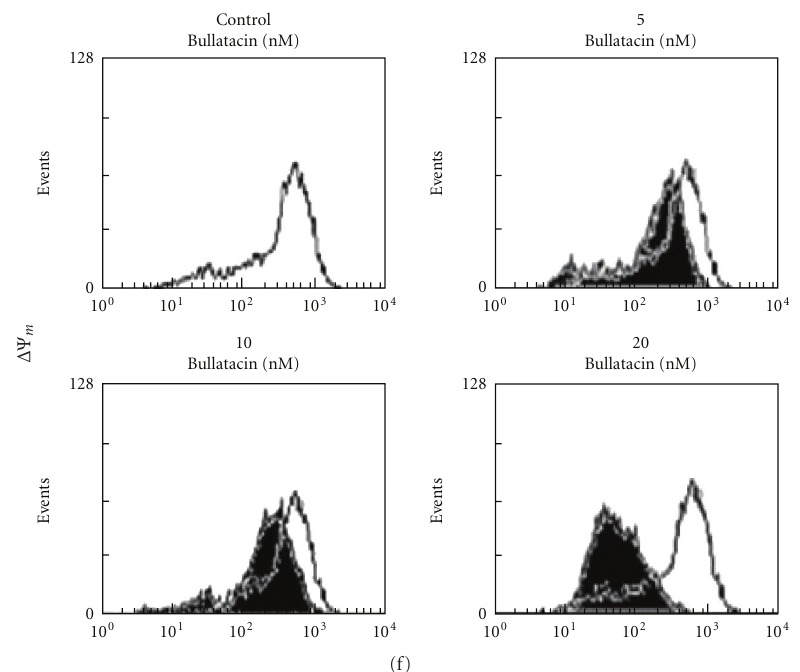
Figure 2: Apoptosis, ROS level and mitochondrial transmembrane potential ( ΔΨ m ) were determined in KB or KBv200 cells after treatment with bullatacin. (a) Apoptotic morphology of KB and KBv200 cells ( × 400) was observed by Hoechst 33258 staining. The experiments were performed three times and a representative experiment is shown. (b) The apoptotic rates of KB and KBv200 cells were calculated with identified apoptosis cells by Hoechst 33258 stain dividing to accounted all cells (more than 2000 cells) after treated with bullatacin for 48 hours. Data represented means and standard errors of at least a triplicate determination. (c) Apoptotic cells were detected with Annexin V/PI after bullatacin treatment for 48 hours. The left-upper quadrant represents cells stained mainly by propidium iodide, while the right bottom quadrant represents cells stained mainly by Annexin V (apoptotic cells). The top right quadrant represents cells stained by both PI and Annexin V (secondary necrosis). The experiments were performed three times and a representative experiment is shown. (d) The apoptotic rates of KB and KBv200 cells was examined with Annexin V/PI after treated with bullatacin for 48 hours. Data represented means and standard errors of at least a triplicate determination. (e) ROS levels detection in KBv200 cells after treatment with bullatacin for 12 hours. Relative ROS levels were represented by the fold DCF intensity compared with untreated cells. The samples were duplicated and the data is a representative of three experiments. (f) Assessment of ΔΨ m collapse in KBv200 cells. The collapse of ΔΨ m was indicated by a reduction of DiOC 6 intensity because the cells lost DiOC 6 staining. Data represented means and standard errors of at least a triplicate